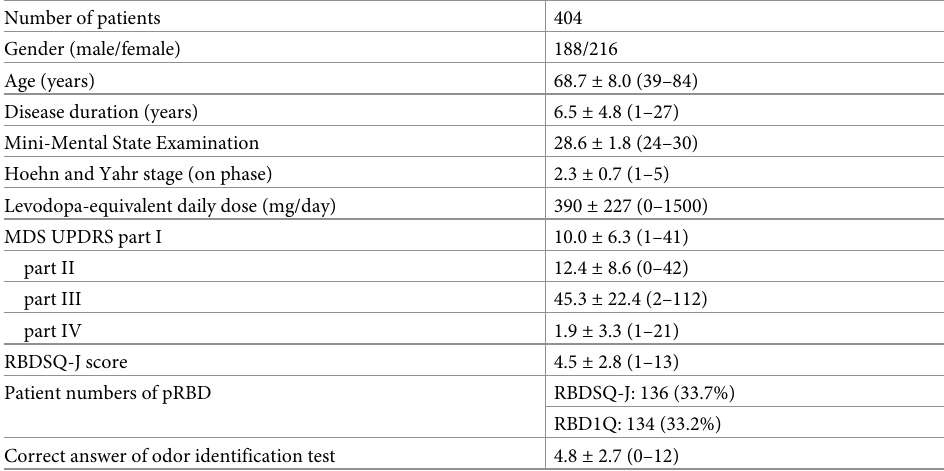
Table 1. Clinical characteristics of total patients with Parkinson’s